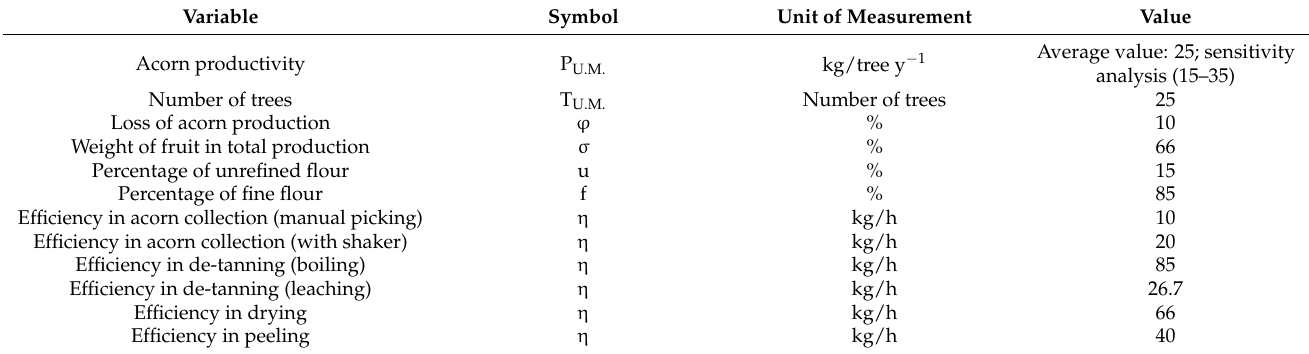
Table 1. Coefficients and unitary values applied in the DSS (Equations